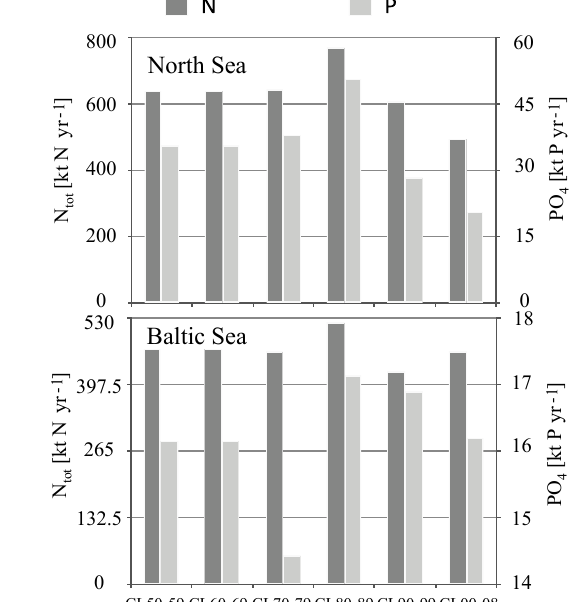
Figure 4. Decadal mean annual nutrient loads N tot (NO 3 + NH 4 ) and PO 4 averaged for each of the six simulation decades for use in the scenario simulations. Note: SiO has also been modified but is not shown